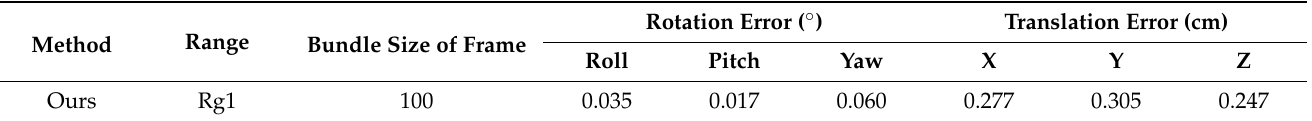
Table 4. Quantitative results of calibration on Oxford dataset with temporal filtering.